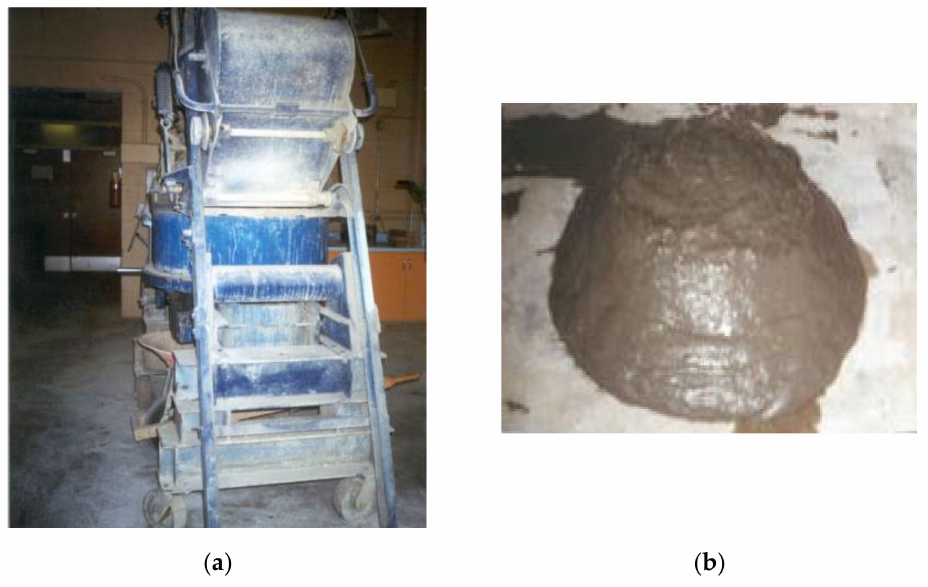
Figure 2. Preparation of mortar composites: ( a ) pan-type mixer used for mixing; ( b ) a portion of freshly mixed